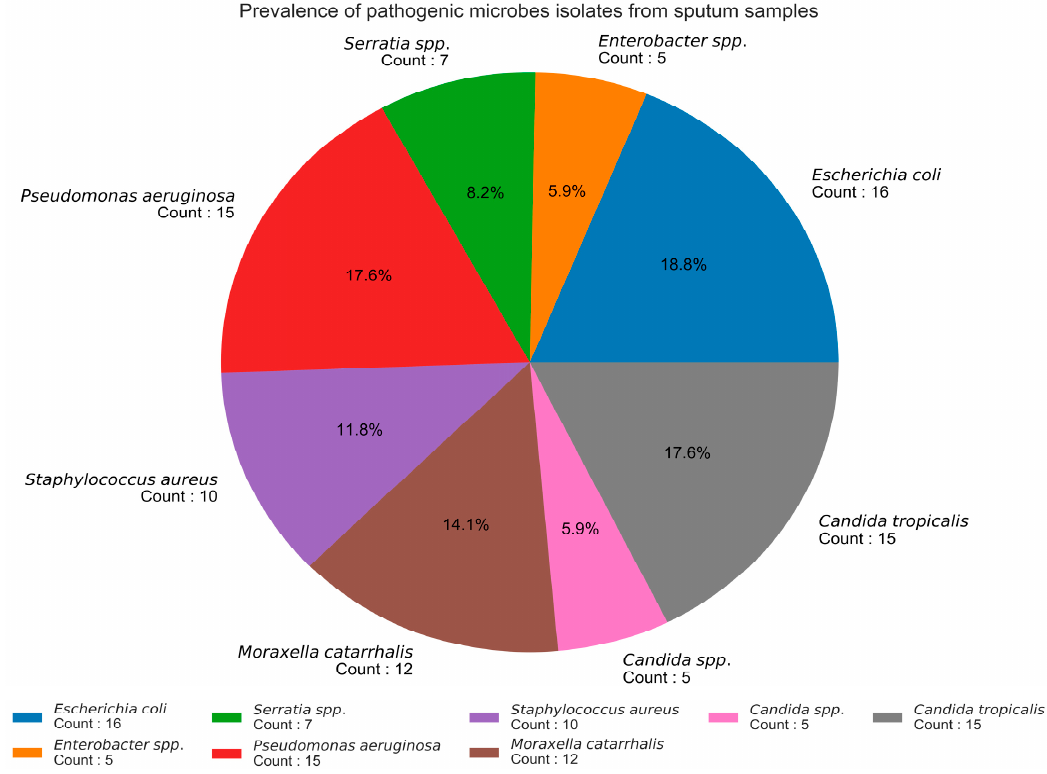
Figure 1. The pie chart shows the percentage prevalence of pathogenic microbial isolates from sputum samples.